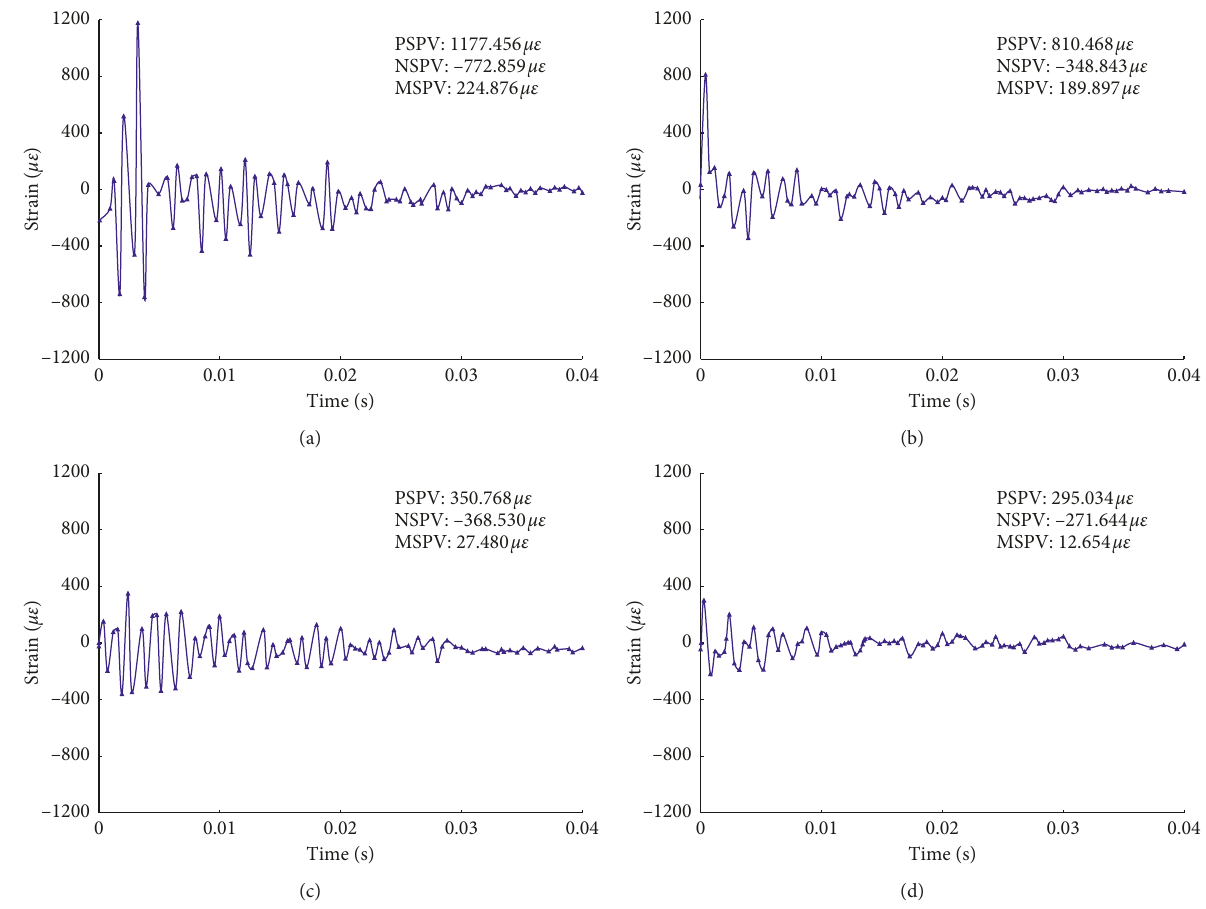
Figure 7: Waveform curve of dynamic strain for #3 test model: (a) #E3-1 test point, (b) #E3-2 test point, (c) #E3-3 test point, and (d) #E3-4 test